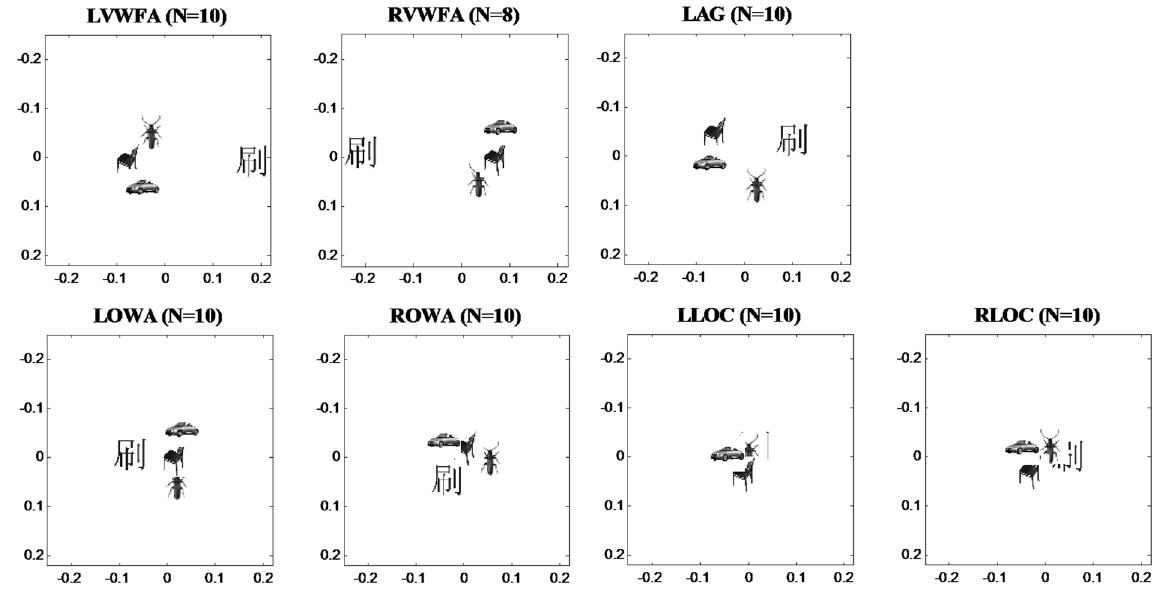
Figure 4. Multi-dimensional scaling. (Dissimilarity: 1- Pearson’r, criterion: stress) for each ROI, stimulus categories with similar activation patterns are placed close together. The distance between stimuli reflects their representational dissimilarity. Left OWA shows a similar representation structure for the four categories as the VWFA, comparing with LOC. But VWFA represents character further from other categories comparing with